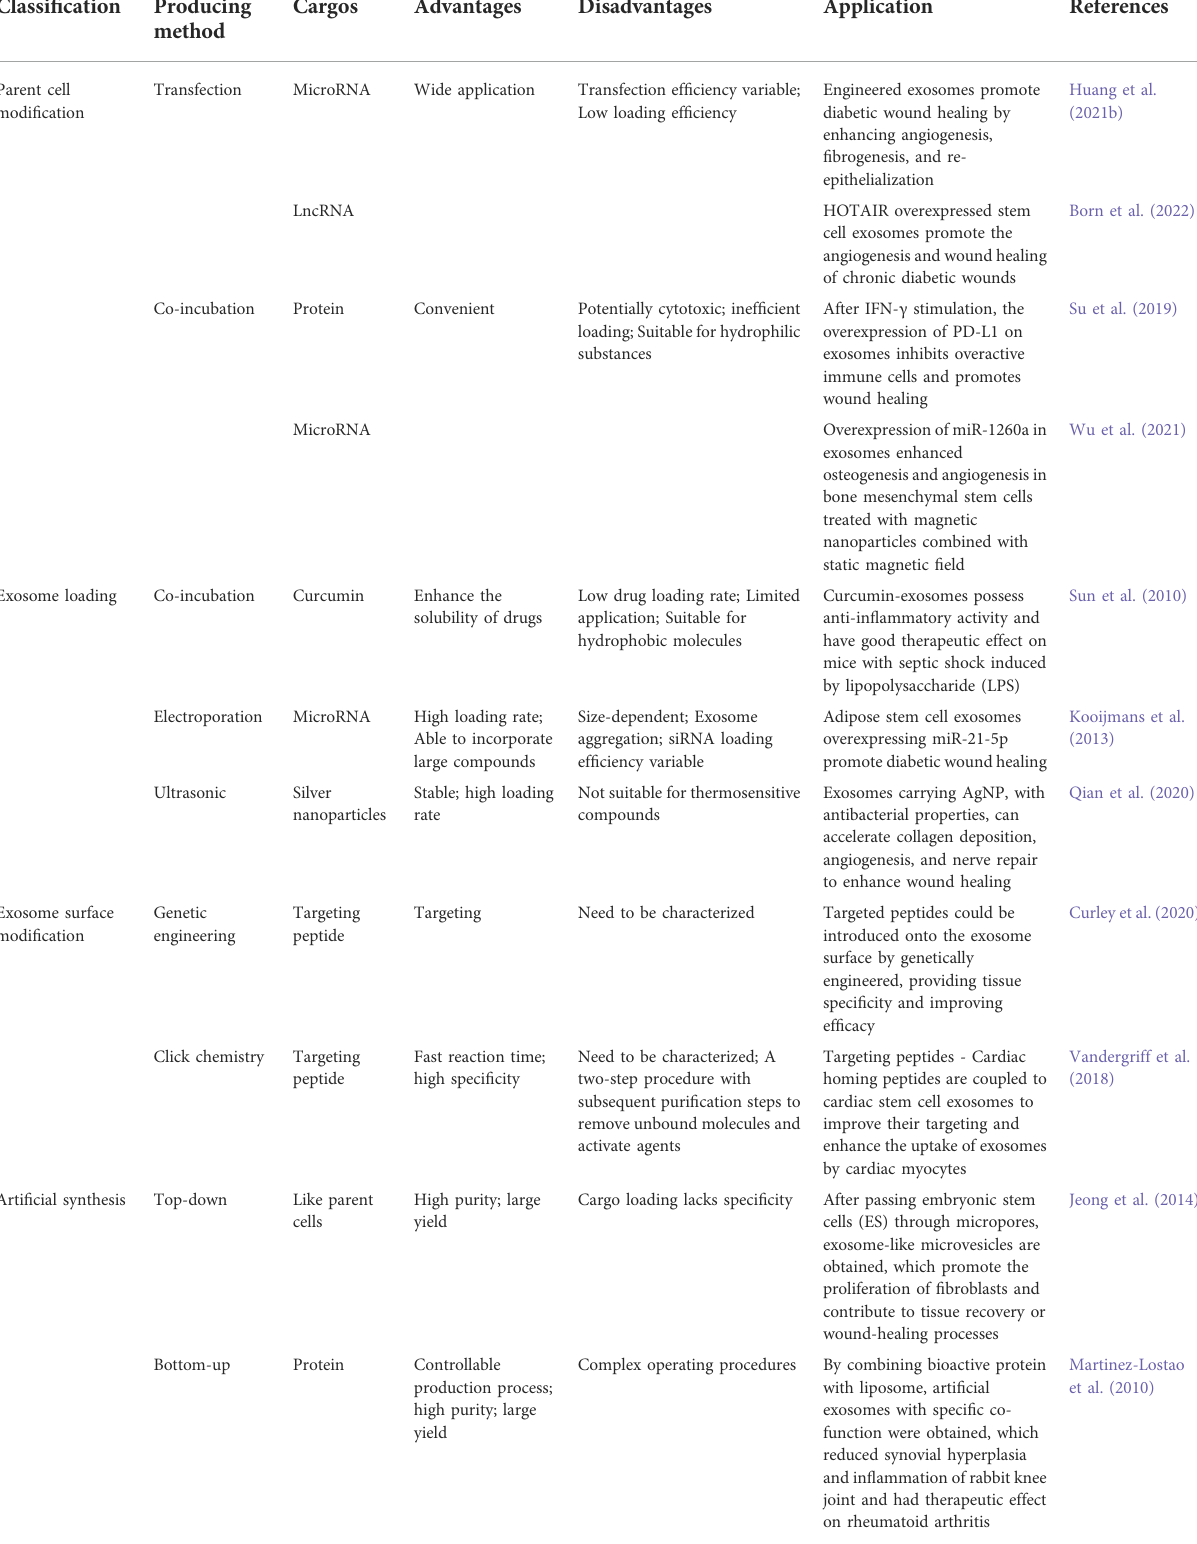
TABLE 2 Synthesis classi fi cation and characteristics of engineered